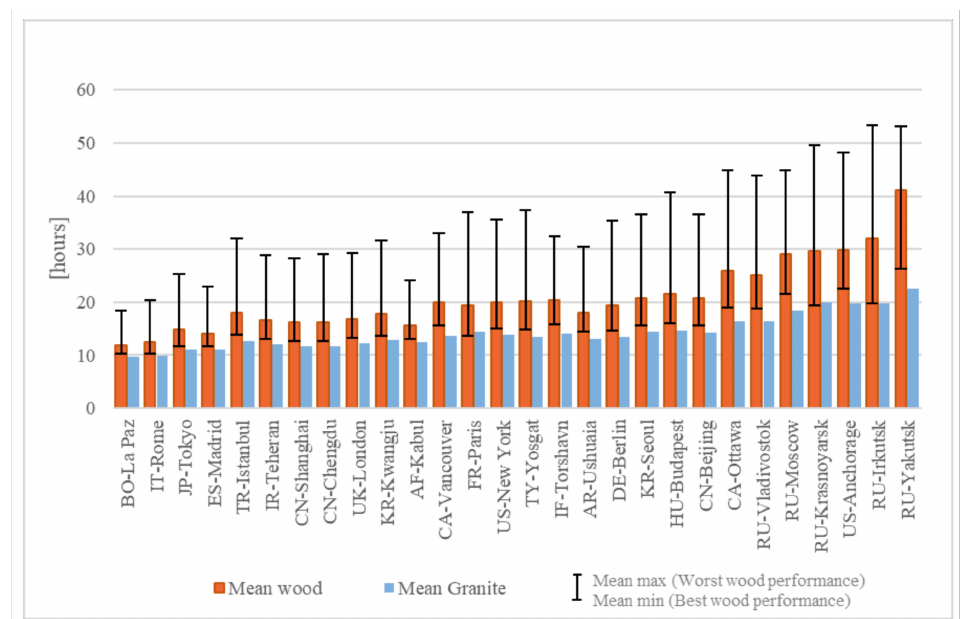
Figure 6. Mean start-up lag times in each